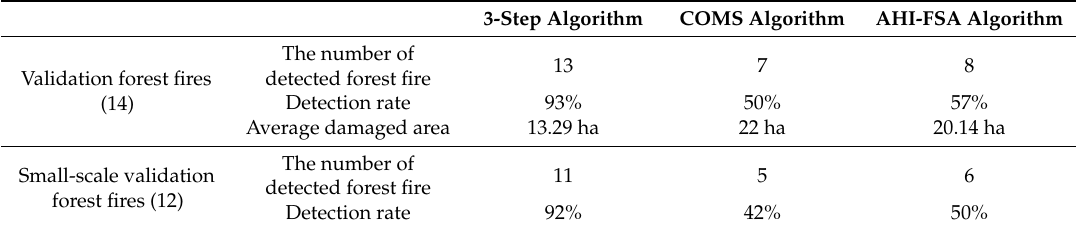
Table 4. The number of detected forest fire and the detection rate of the proposed 3-step algorithm, the COMS algorithm, and the AHI-FSA